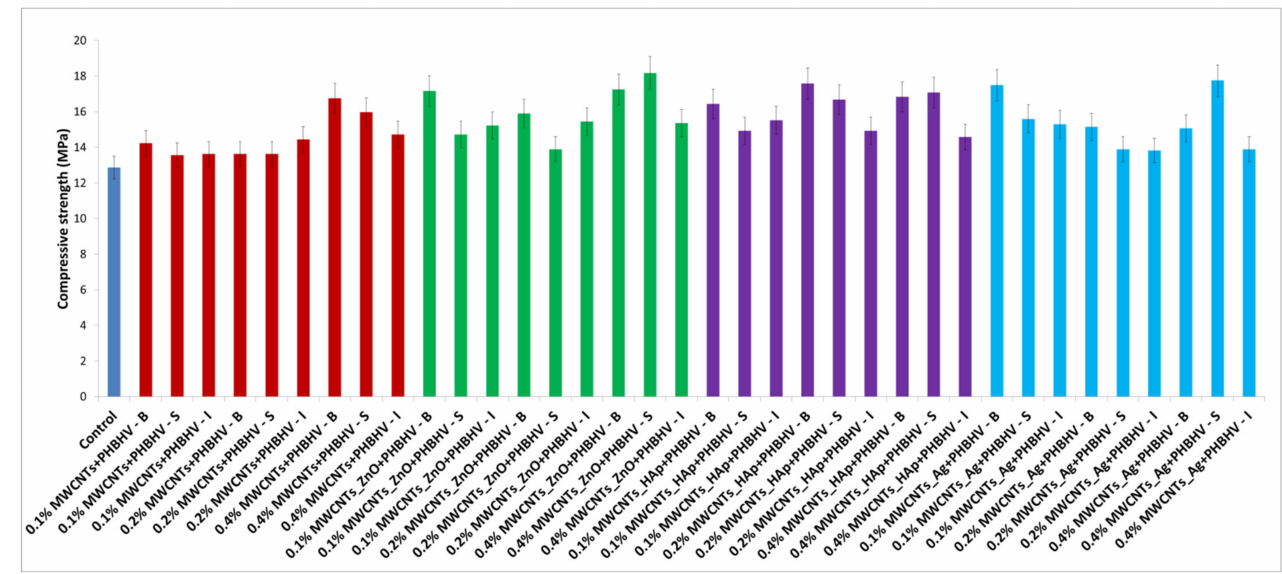
Figure 9. Compressive strength of untreated and treated samples. Table 4. ANOVA, mechanical improvement achieved with